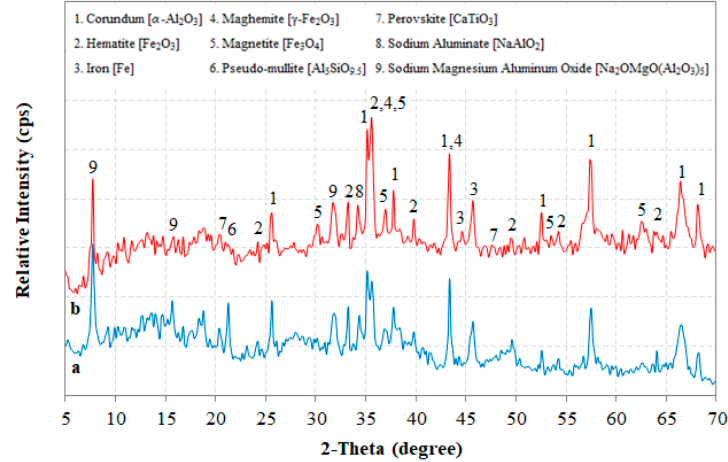
Figure 17. XRD patterns of ( a ) non-magnetic product and ( b ) magnetic product obtained after reduction roasting followed by magnetic separation when carbon to bauxite (C/B) ratio was 0.15.